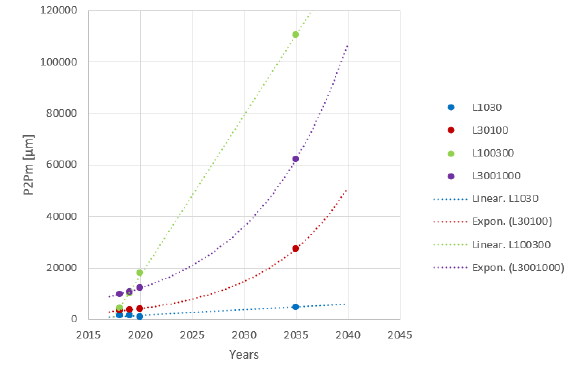
Figure 6. Wave defects development prediction based on the previous measurements done by the Track recording car.